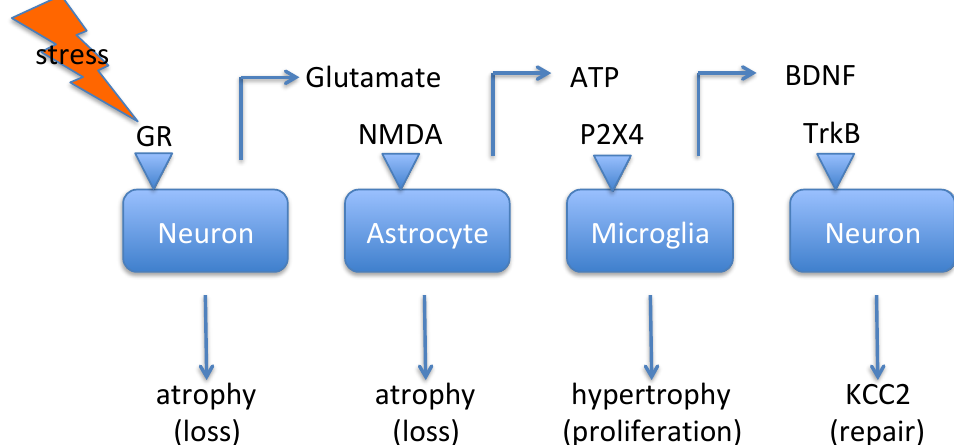
Figure 1. This scheme is based upon data published by [44,58]. Stress activates a sequence of events that involves neuron-derived glutamate, astrocyte-derived ATP, and microglia-derived brain-derived neurotrophic factor (BDNF), and ultimately results in higher network excitability. Since stress induces dendritic atrophy, the elevated network excitability might serve a repair function. Legend: GR, glucocorticoid receptor; NMDA, N-methyl-D-aspartate; TrkB, tropomyosin receptor kinase-B; KCC2, K-Cl-cotransporter-2. ATP also stimulates microglia to assemble the components of the ‘NOD-, LRR- and pyrin-domain-containing protein 3′ (NLRP3) inflammasome [58]. The NLRP3 inflammasome mediates the cleavage of pro-interleukin-1β (pro-IL1β) to mature IL1β [34] and sensitizes microglia to generate a stronger pro-inflammatory response [61]. Frank et al. have exposed rats to inescapable tail shocks. They noted that the responsiveness of hippocampal microglia to lipopolysaccharide (LPS) was raised by the tail-shock procedure, but, notably, this sensitization was absent if the rats had been adrenalectomized or treated with the GR-antagonist RU486 prior to the tail shocks [61]. Chronic stress reduced the dendritic connectivity and size of the hippocampus and prefrontal cortex (PFC) [62–64], while inhibition of NMDA receptors or inhibition of glutamate-release blocked the effect of chronic stress on dendritic atrophy (reviewed by [57]). Stress-induced reduction in neuropil is likely to contribute to impairment in cognitive function [65,66].